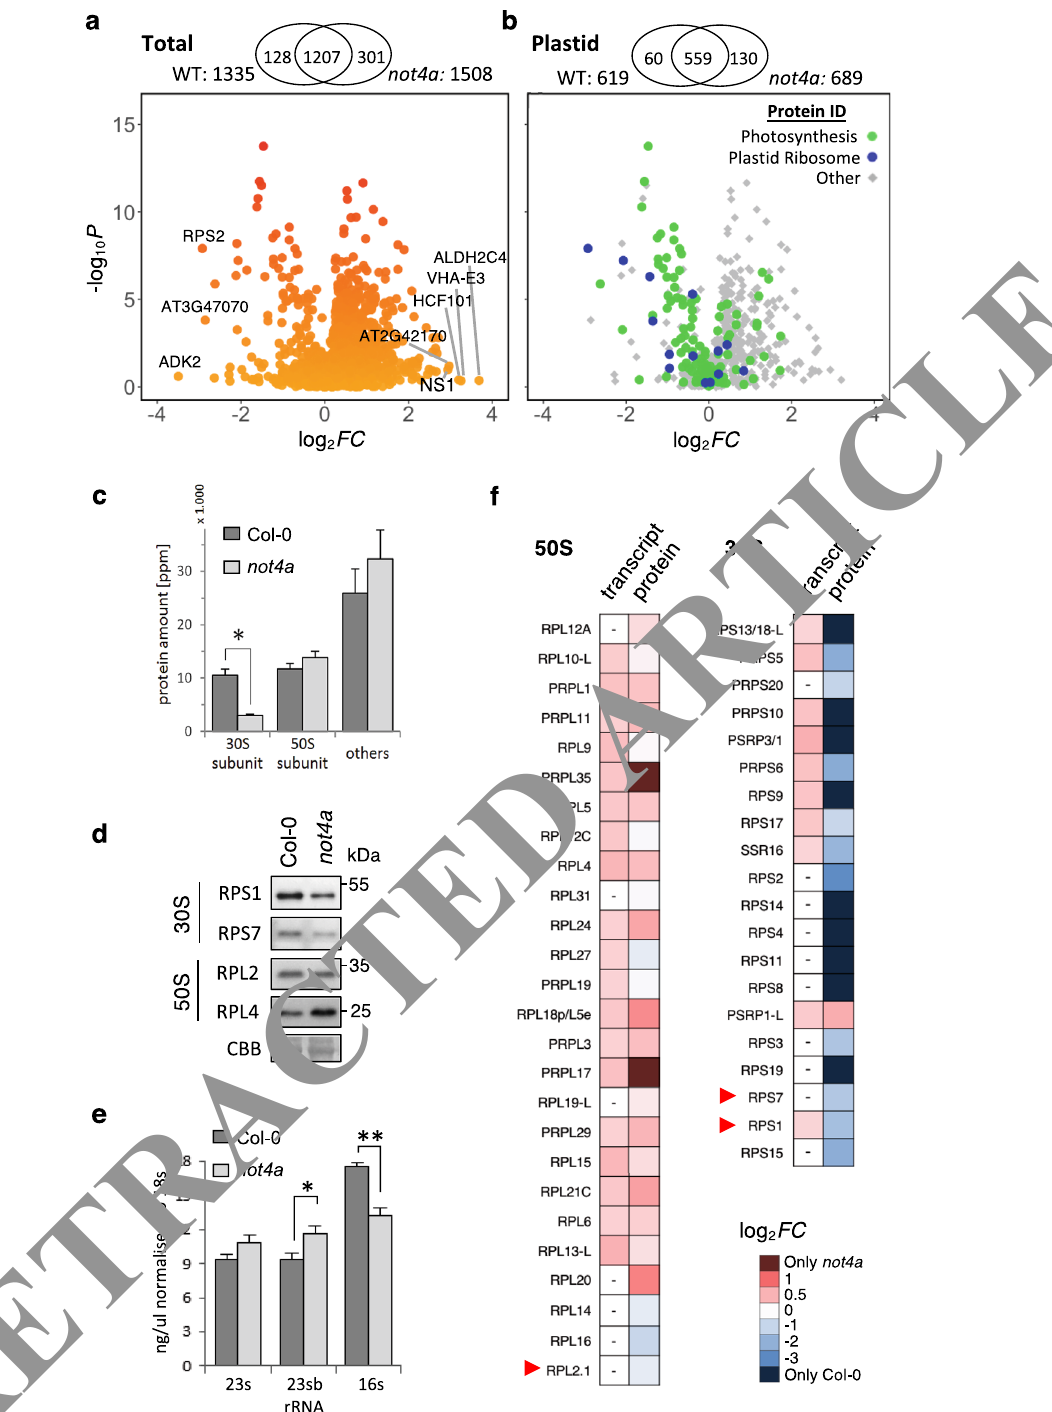
The not4a mutant mimics the pgr3 mutant . To identify potential causal agents of the phenotypic defects in not4a we analysed the DEGs annotated with chloroplast functions (GO:0009507) in the not4a RNA-seq dataset (Fig. 6a, Supple- mentary Data 1). A total of 819 DEGs were identi fi ed, with a vast majority of these (693) being upregulated relative to WT. Amongst these genes were 34 chloroplast-targeted PPR proteins, which collectively may be upregulated to compensate for com- promised chloroplast translation in the mutant